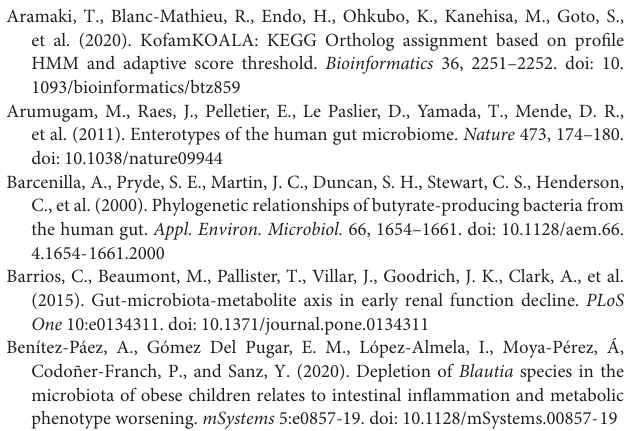
Supplementary Table 2 | List of the Blautia RefSeq genome assemblies utilized in this study. Supplementary Table 3 | Genomic pairwise calculations for ANI, TETRA, and AAI obtained from the Blautia dataset and the outgroup